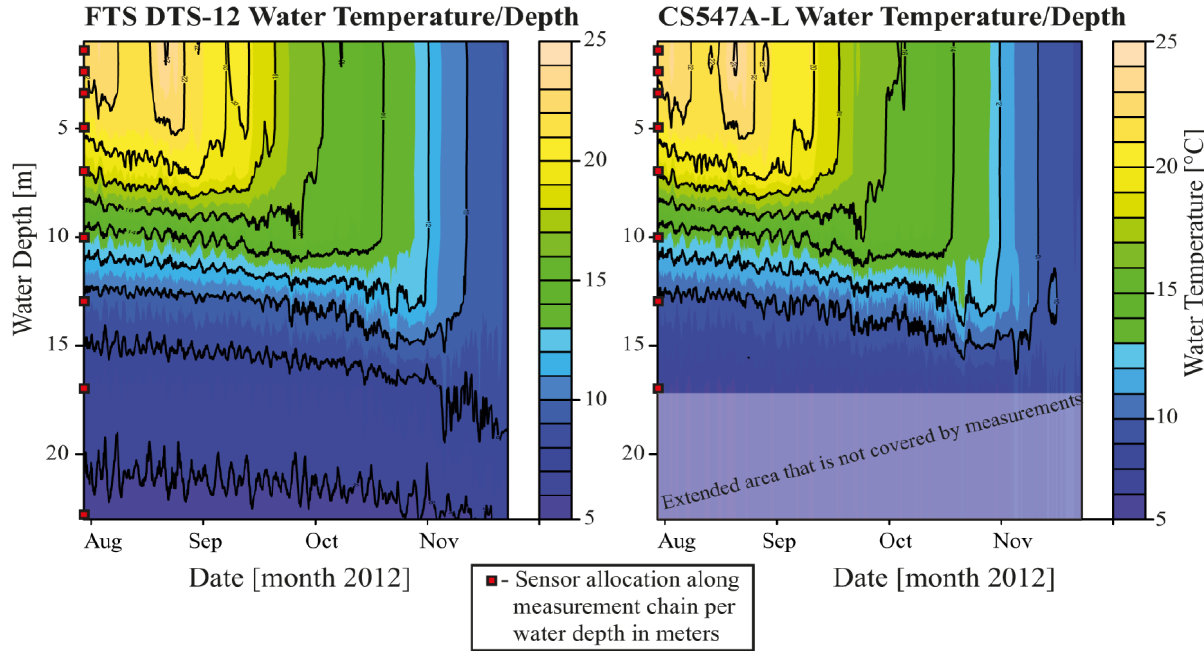
Figure 5. Measured water temperature by depth as a contour plot recorded by two different sensors. The FTS DTS-12 on the left and the CS547A-L on the right. Sensor allocation by water depth is illustrated by the red